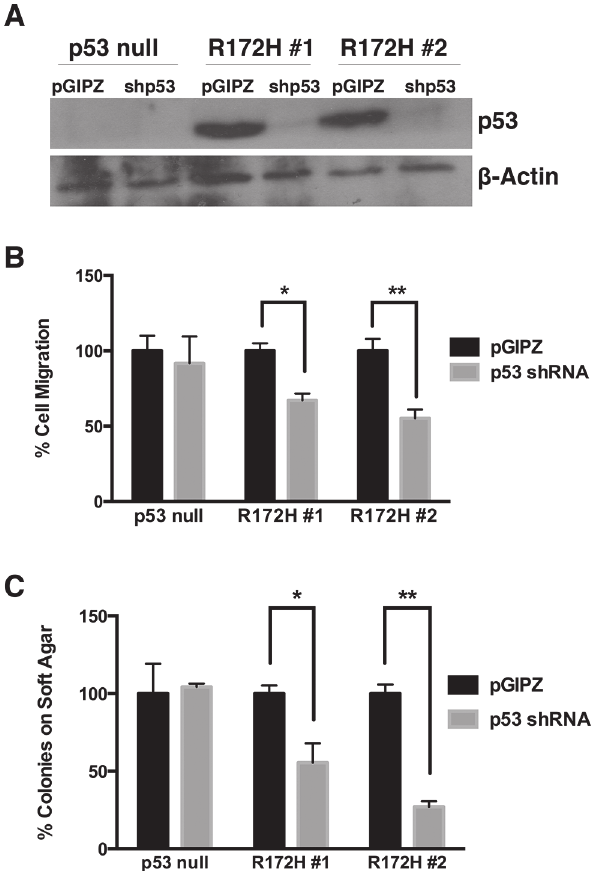
Fig 3. p53 R172H is required for transformation-related phenotypes in HCC cell lines. A) Immunoblot of p53 depicting 3 HCC cell lines infected with shRNA as compared to an empty vector control labeled pGIPZ. B) Transwell migration assay of p53 shRNA-infected HCC cell lines. A p53-null cell line was used as an experimental control. p-values, calculated by Student ’ s t-test, are 0.020 and 0.022 for R172H lines 1 and 2, respectively. The number of migrating cells in each pGIPZ control infection was set to 100%. C) Soft agar colony formation assay of p53 shRNA-infected HCC cell lines. A p53-null cell line was used as an experimental control. p-values, calculated by Student ’ s t-test are 0.044 and 0.004 for R172H lines 1 and 2, respectively. The number of colonies for each pGIPZ control infection was set to